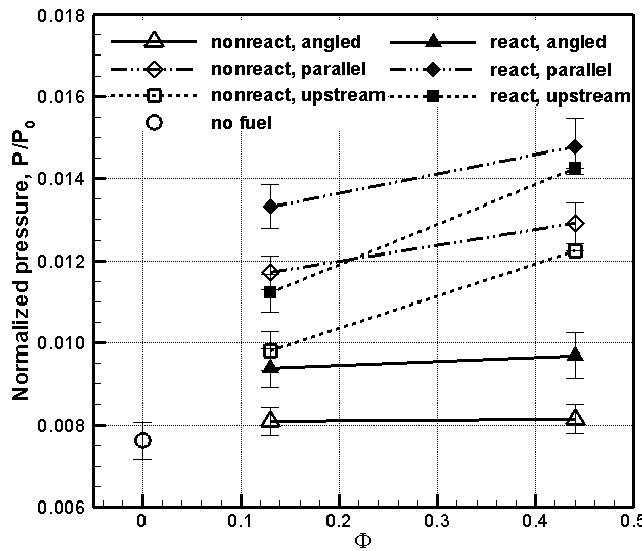
Figure 6. Cavity pressures according to the injection location, Φ , and combustion existence.